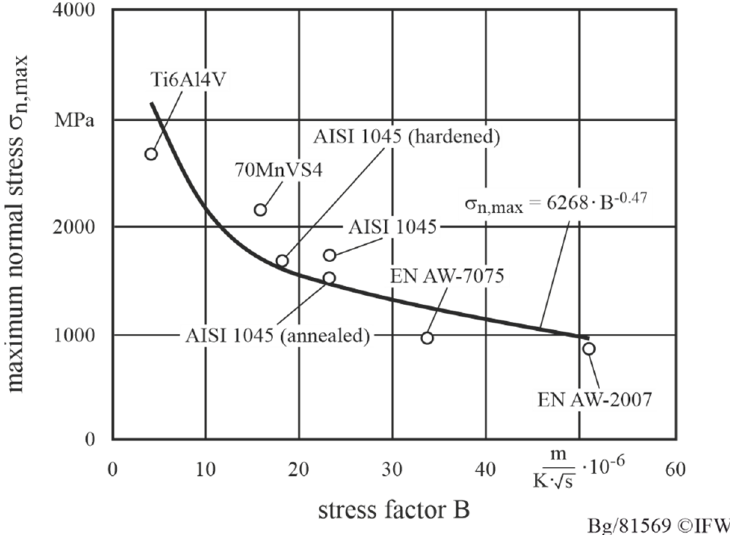
Figure 4. Material-based modelling of the load stresses on the rake face.